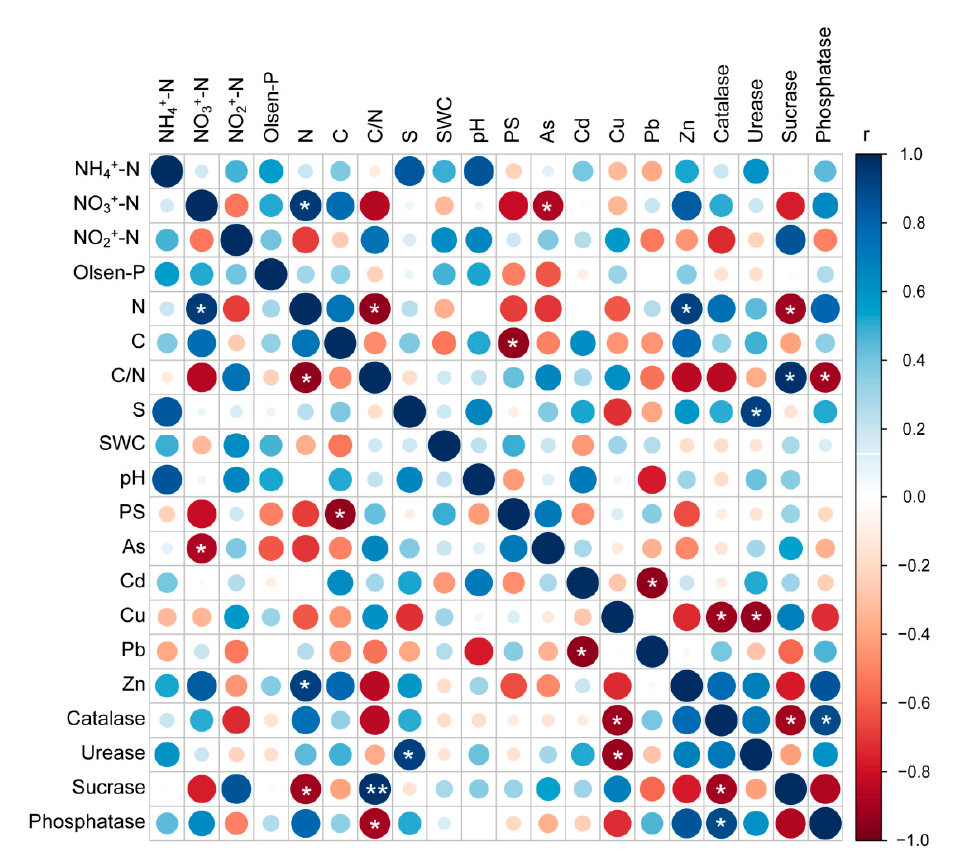
Figure 4. The Pearson correlations among soil physicochemical properties, soil heavy metals and soil enzymes in non-rhizophere soil. Physical and chemical properties of soil included total nitrogen (N), total carbon (C), total sulphur (S), ration of carbon and nitrogen (C/N), soil water content (SWC), soil pH, particle size (PS), ammonium nitrogen (NH 4+ -N), nitrate nitrogen (NO 3 − -N), nitrite nitrogen (NO 2 − -N), and Olsen-P. * Correlation is signi fi cant at the 0.05 level (2-tailed).